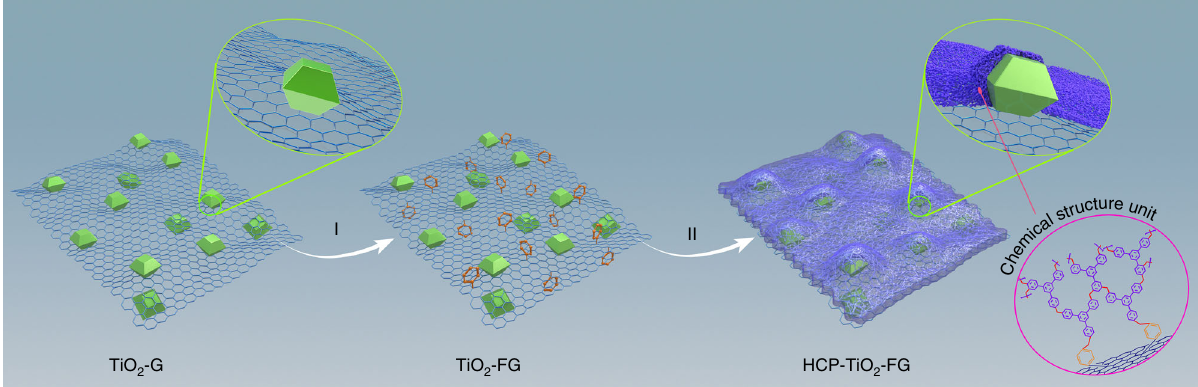
Fig. 1 Construction of a well-de fi ned porous HCP-TiO 2 -FG composite structure. I The functionalization of TiO 2 -G by diazonium salt formation. II The knitting of TiO 2 -FG with syn -PhPh 3 by solvent knitting method. The magni fi ed model in the top right corner is the cross pro fi le of HCP-TiO 2 -FG